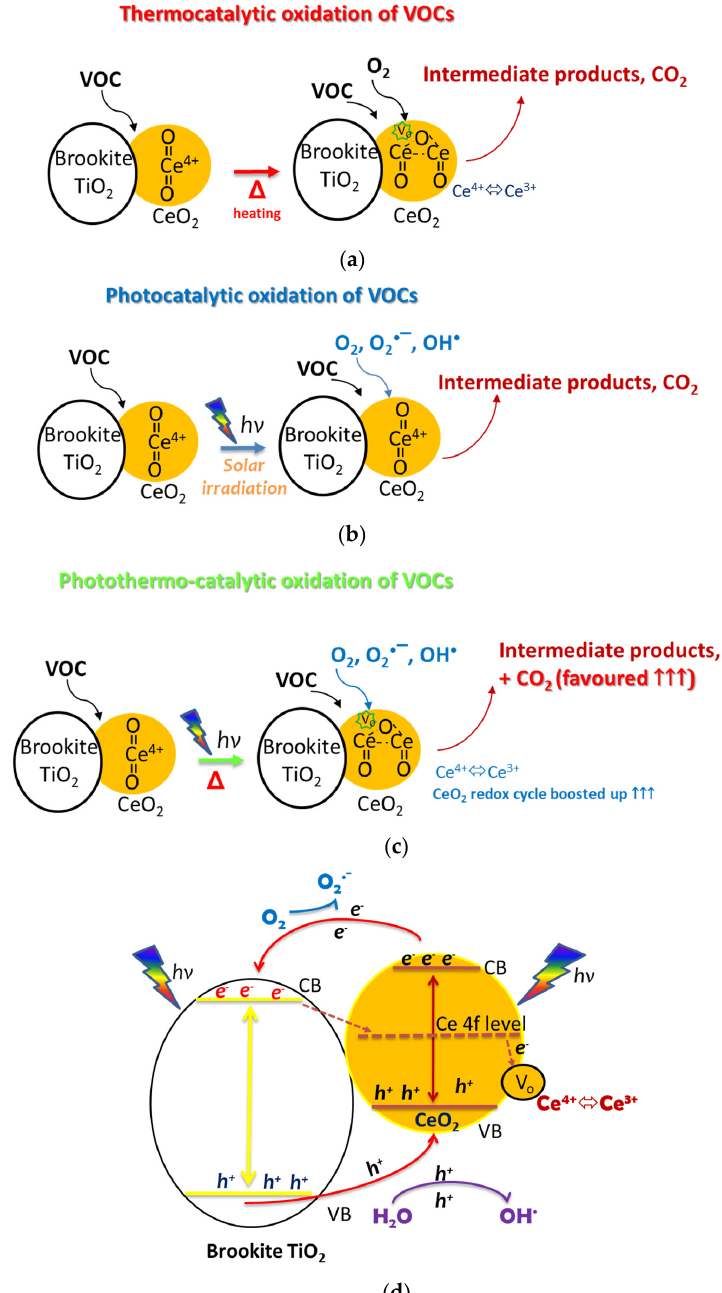
Figure 11. Reaction scheme of ( a ) the thermocatalytic oxidation of the volatile organic compounds (VOCs); ( b ) the photocatalytic oxidation of VOCs; ( c ) the photothermo-catalytic oxidation of VOCs, ( d ) the charge carrier separation on the brookite TiO 2 –CeO 2 composites. V o represents an oxygen vacancy.